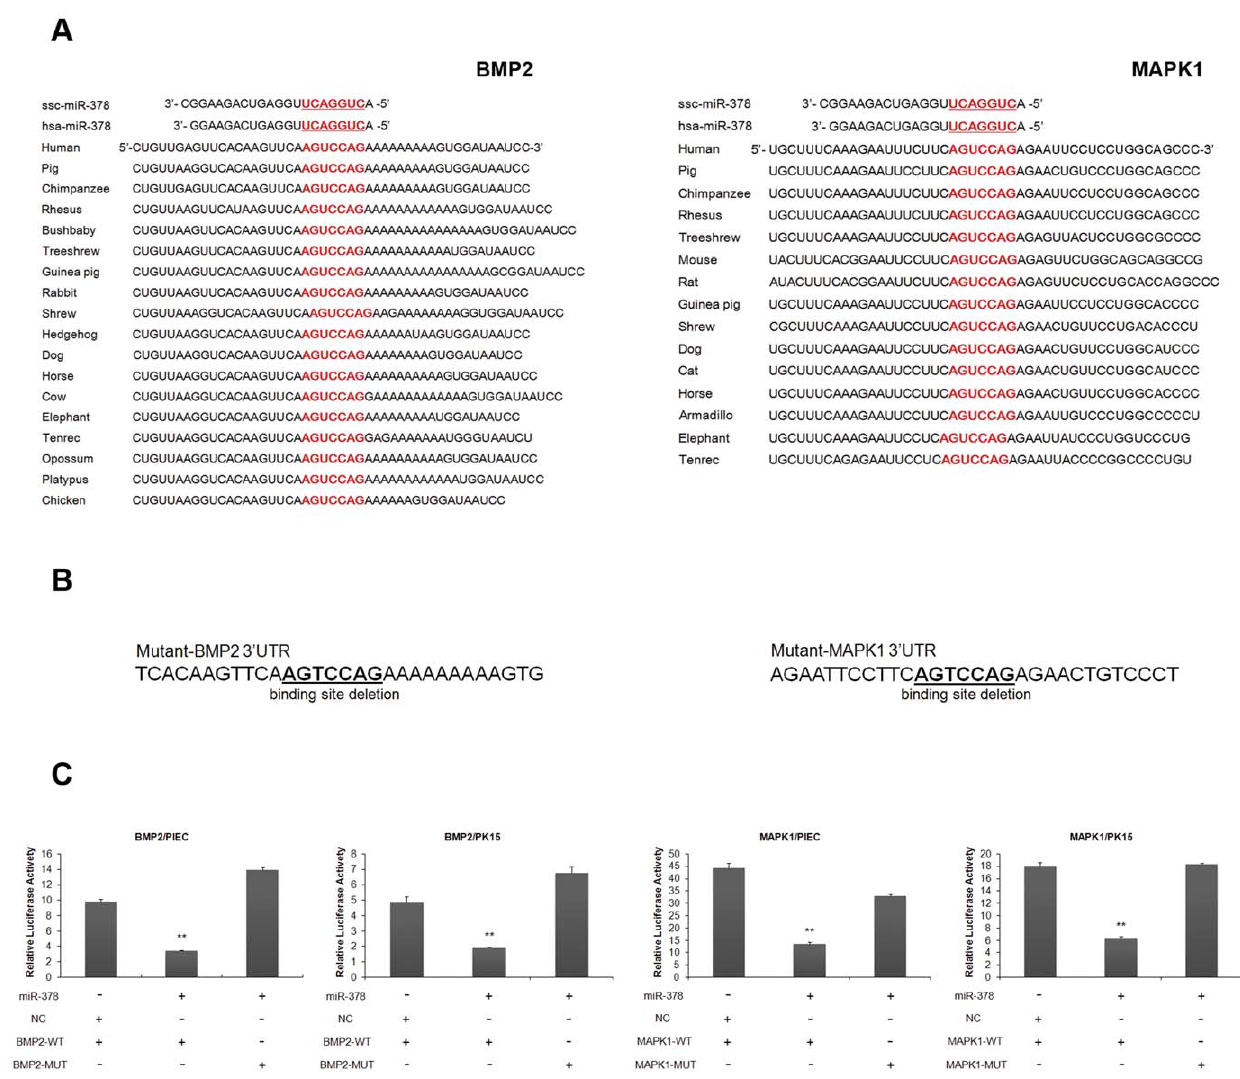
Figure 4. BMP2 and MAPK1 are potential target of miR-378. (A) Predicted miR-378 binding site (highlighted in red) in the 3 9 UTR of BMP2 or MAPK1 showing species conservation. (B) Schematic of the predicted miR-378 binding sites (underlined) in the 3’ UTR of BMP2 or MAPK1. The region of binding sites were deleted in the mutant 3’ UTR reporters. (C) Luciferase activety assay of the wild-type (WT) or mutant (MUT) 3 9 UTR of BMP2 and MAPK1 using a dual luciferase reporter system in PIEC or PK15 cell lines following co-transfection with miR-378 mimics or negative control mimics (NC). Data is derived from triplicate tranfectants of 3 independent experiments (**p , 0.01). doi:10.1371/journal.pone.0052123.g004 143-3p, ssc-miR-10b, ssc-miR-148a, ssc-miR-127, ssc-miR-30d, ssc-miR-30a-5p, and ssc-miR-181a. The let-7 family is a conserved family of miRNAs, the members of which behave as tumor